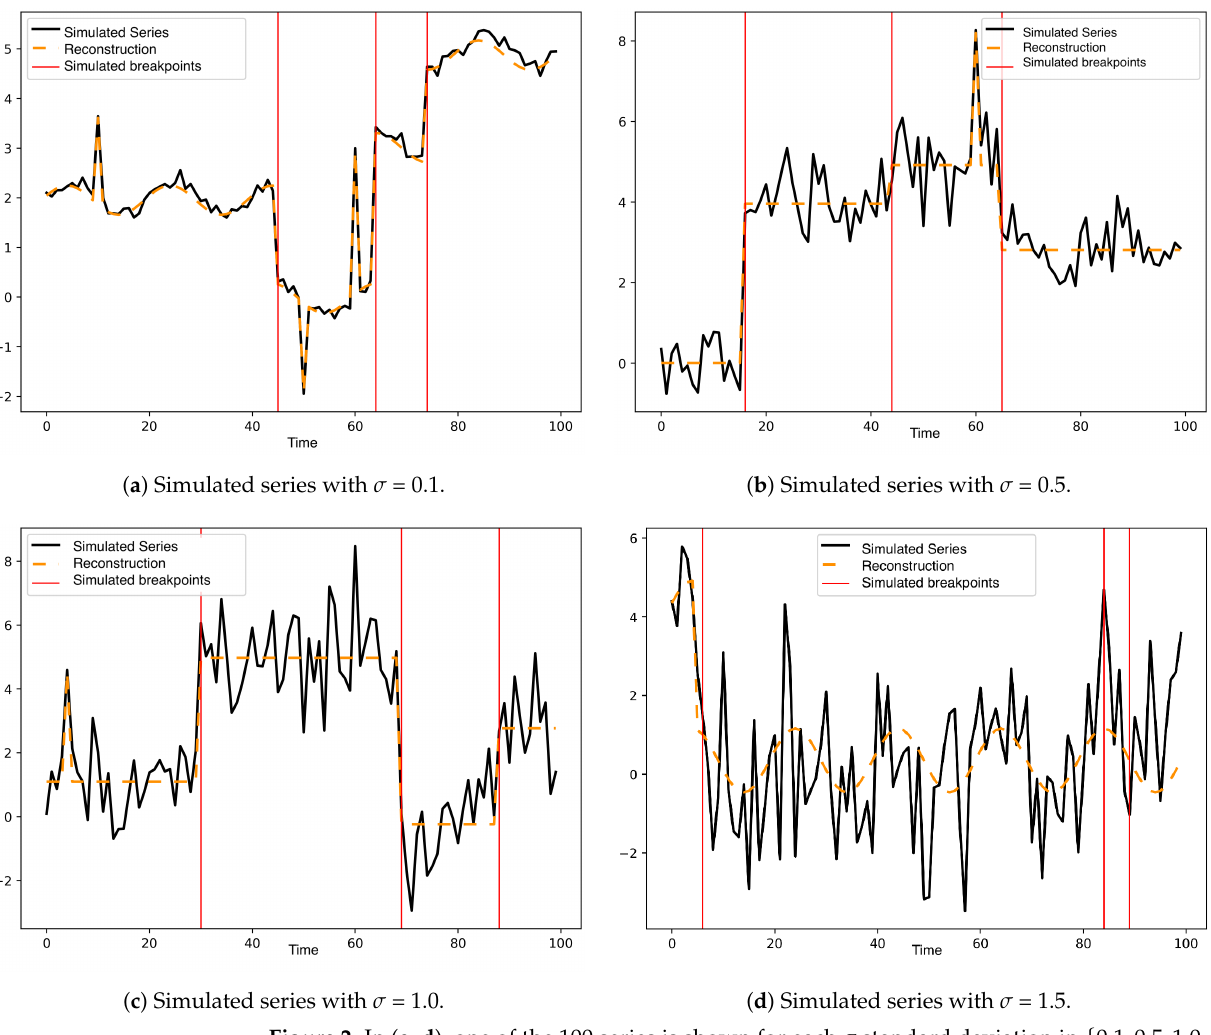
Figure 2. In ( a – d ), one of the 100 series is shown for each σ standard deviation in { 0.1,0.5,1.0,1.5 } including the adjusted